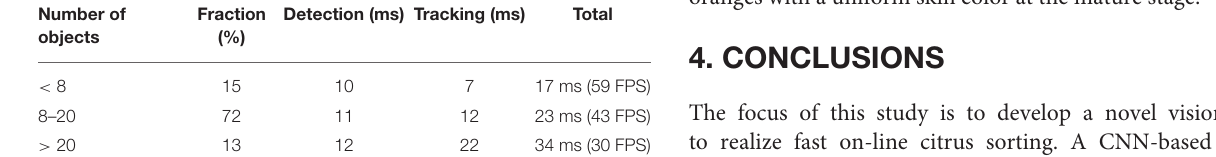
TABLE 3 | Average running time of detection and tracking algorithms. Number of